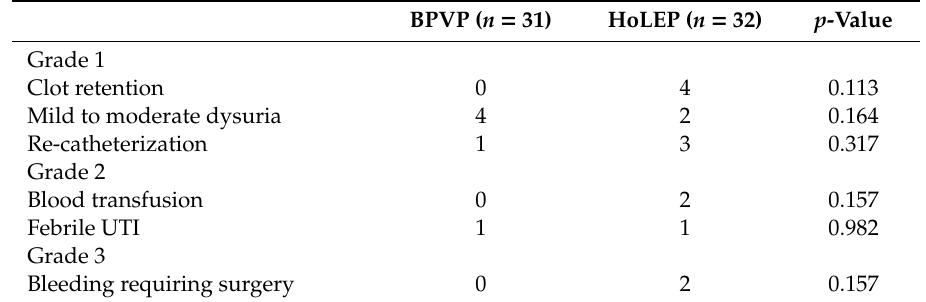
Table 3. Postoperative complications of BPVP and HoLEP group with modified Clavien Classification.